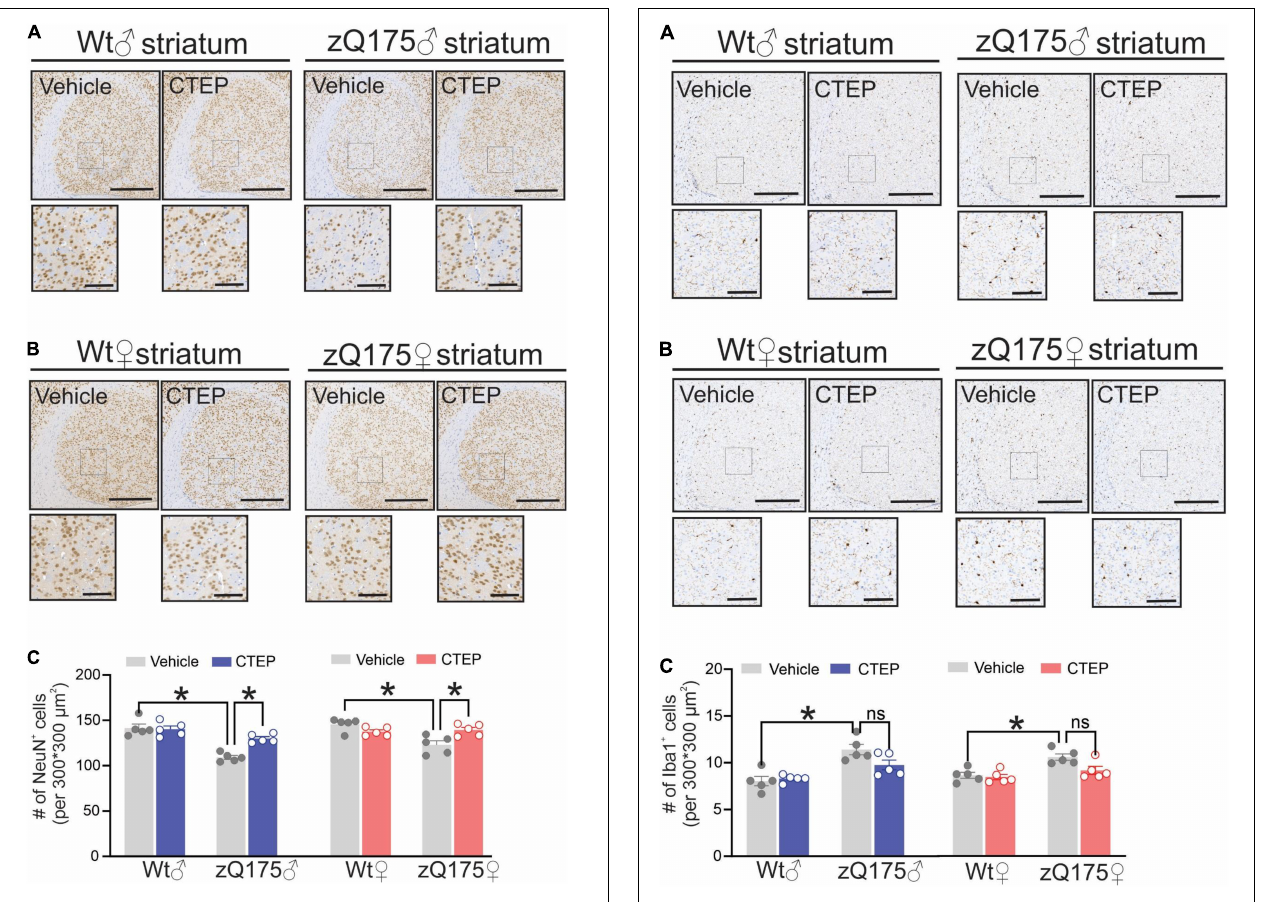
FIGURE 6 | Effect of chronic administration of CTEP on microglia activation in male and female zQ175 mouse striatum. Representative images of staining for ionized calcium binding adaptor molecule 1 (Iba1)-positive cells in striatal brain slices from 15-month-old male (A) and female (B) heterozygous zQ175 (zQ175) and wild-type (Wt) mice after 12 weeks of treatment with either vehicle or CTEP (2 mg/kg/48 h). Scale bar = 500 µ m for whole striatum and 100 µ m for magnified areas. (C) quantification of the number of Iba1-positive cells in striatal brain slices from 15-month-old male and female zQ175 and Wt mice after 12 weeks of treatment with either vehicle or CTEP. Data are quantified from two different 300 × 300 µ m 2 striatal regions of 6 sections per mouse and five independent mouse brains from each group were used for analysis. Data are mean ± SEM. * P < 0.05 by three-way analysis of variance (ANOVA) and Tukey’s multiple comparisons